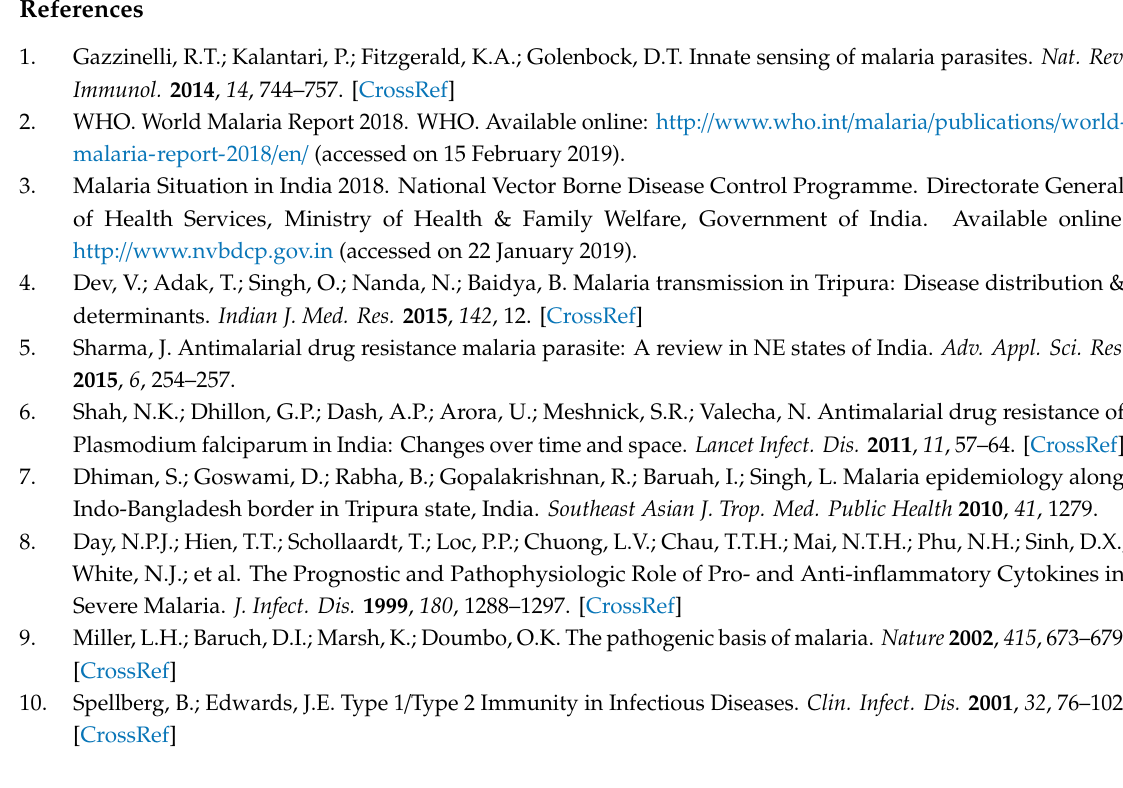
Supplementary Table S1: Fold change analysis of cytokines and signaling molecules compared to both the Endemic and Non-Endemic healthy controls. Supplementary Figure S1: Protein-protein interaction